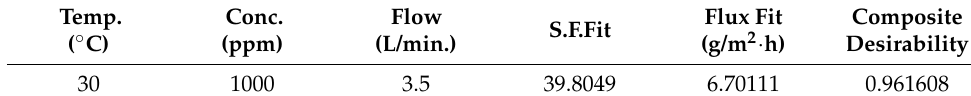
Table 7. Model summary for benzene permeate flux and separation factor.